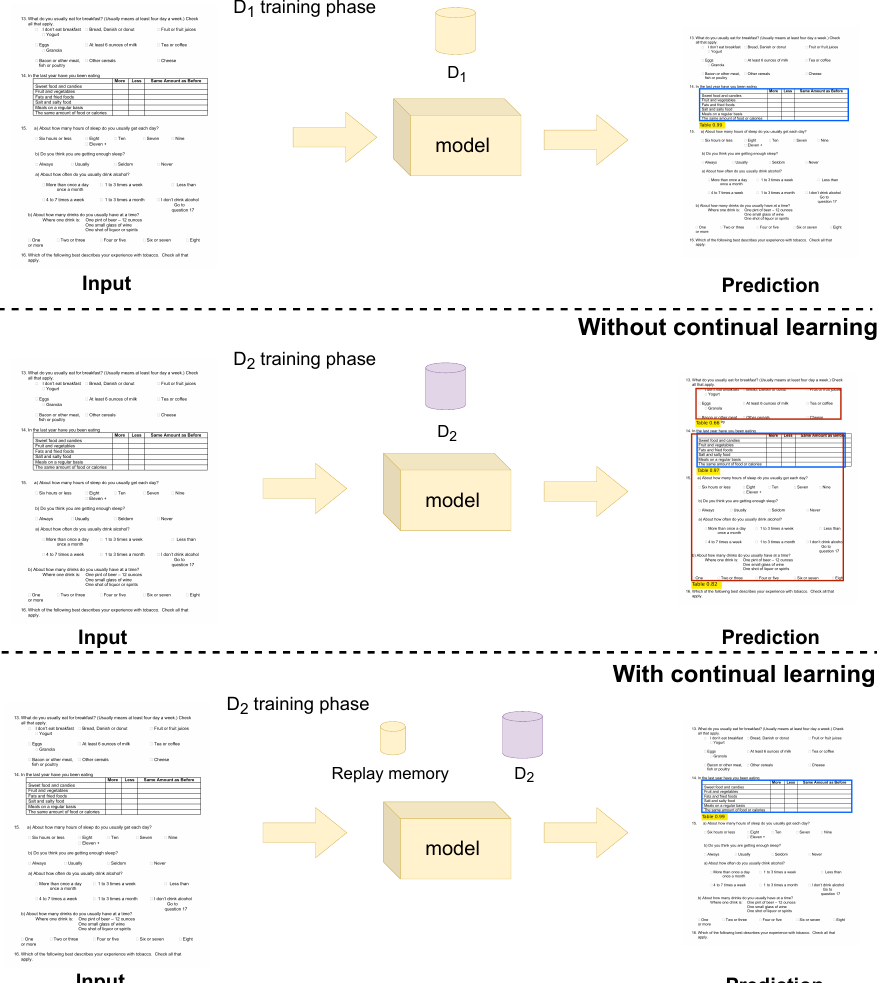
Figure 1. Illustrative sketch of the continual learning usage. After the first training phase ( top row), conventional methods take the same approach for the next datasets ( middle row). CL methods can involve previous knowledge in the latest trains by replaying them for the model ( bottom row). Blue represents true positive, and red denotes false